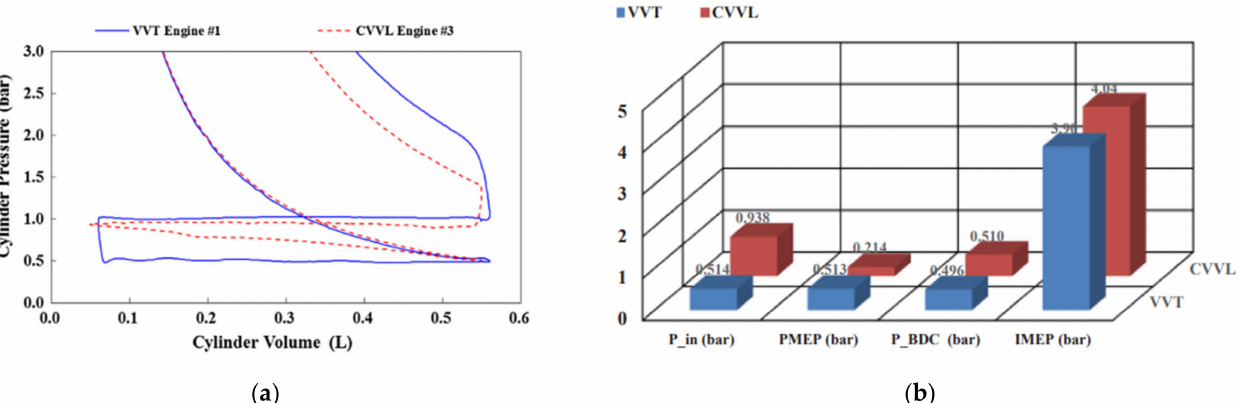
Figure 11. Quantitative analysis of influential factors in pumping loss reduction by VVT and CVVL engines [63]. ( a ) Measured P-V indicator diagram of a VVT engine and a CVVL engine, ( b ) Comparisons of gas exchange performance between engines with VVT and